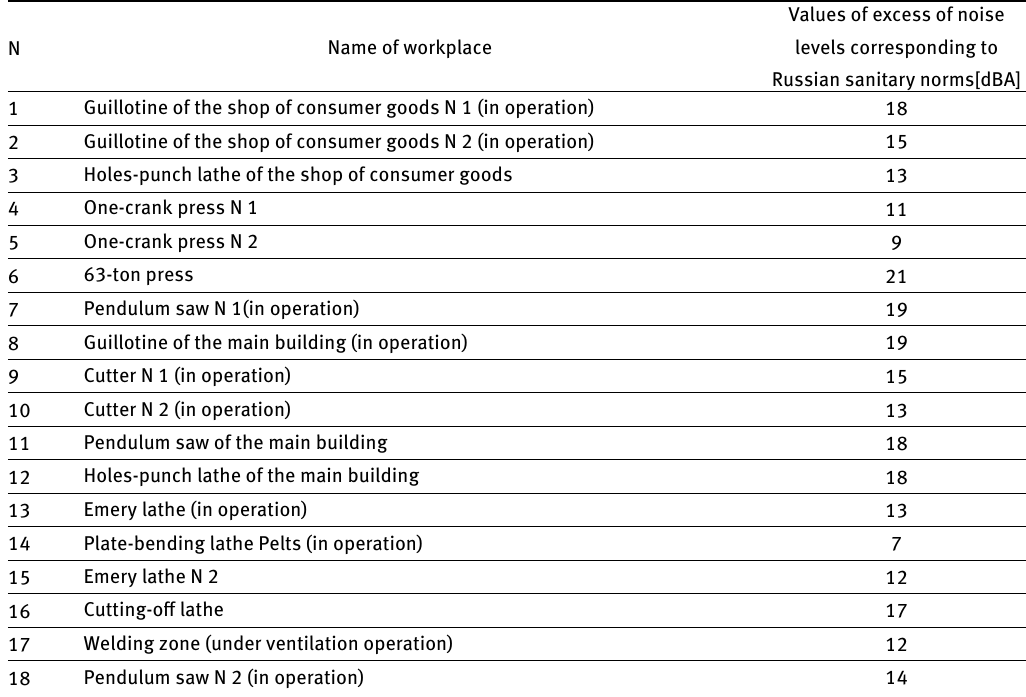
Table 1: Summary of the results of measurements of noise levels in working places of “Volgoelectromontazh 1” joint stock company (values of excess of noise levels corresponding to Russian sanitary